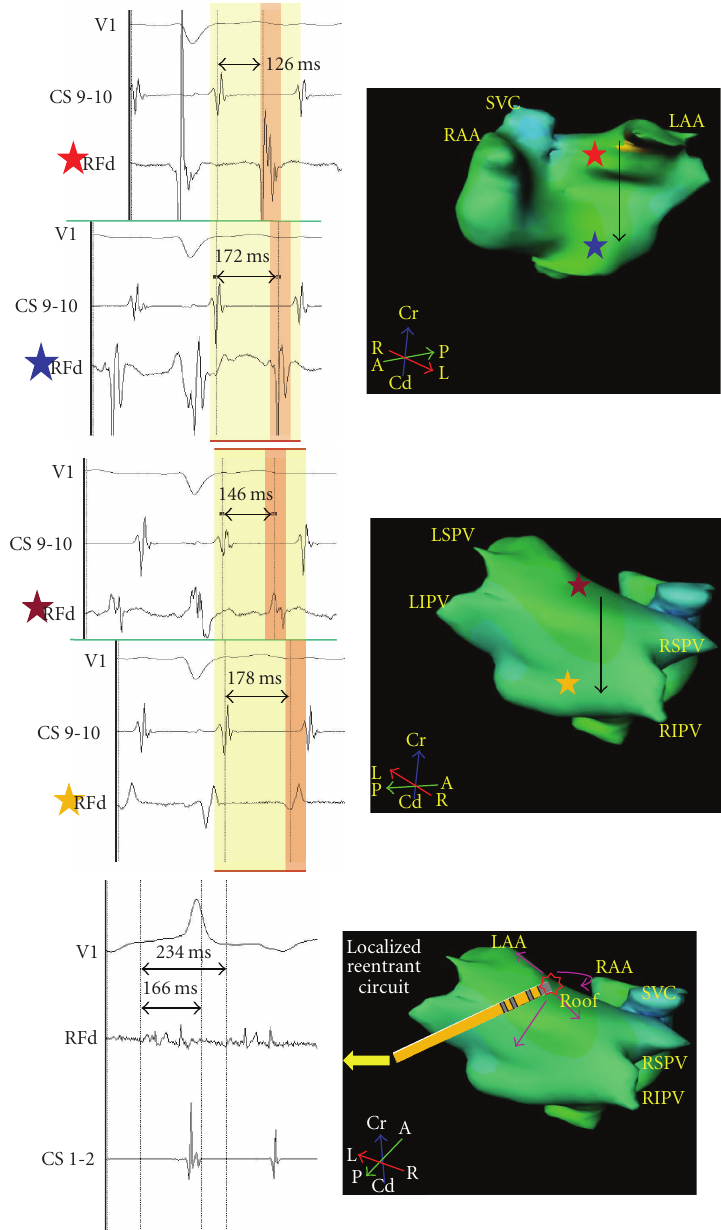
Figure 5: Top: The electrogram recordings from four sites (red, blue, yellow, and maroon stars) on anterior and posterior left atriums are timed with coronary sinus dipole (CS 9-10) as reference. Local electrograms recorded from high (red star) and low (blue star) anterior sites are 126 ms and 172 ms, respectively from the reference suggestive of high to low anterior left atrial activation pattern. Local electrograms recorded from the high (maroon star) and low (yellow star) posterior sites are 146 ms and 178 ms, respectively from the reference suggestive of high to low posterior left atrial activation pattern. This pattern which rules out macroreentry is consistent with focal tachycardia arising from a focus. Bottom: Focus is shown in the roof shown as “ ”. The arrows display centrifugal activation of the atria. Ablation catheter (RF) records continuous low voltage (0.176 mV) electrical activity spanning 166ms during atrial tachycardia (cycle length 234 ms). Recording 71% of tachycardia cycle length at a single spot suggests localized reentry as the mechanism of